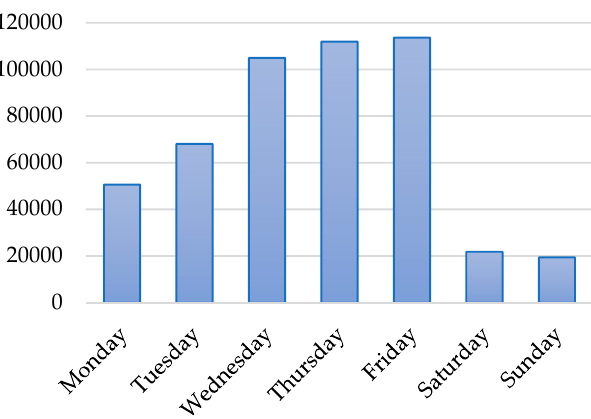
Figure 3. Total tweet distribution according to days of the week.